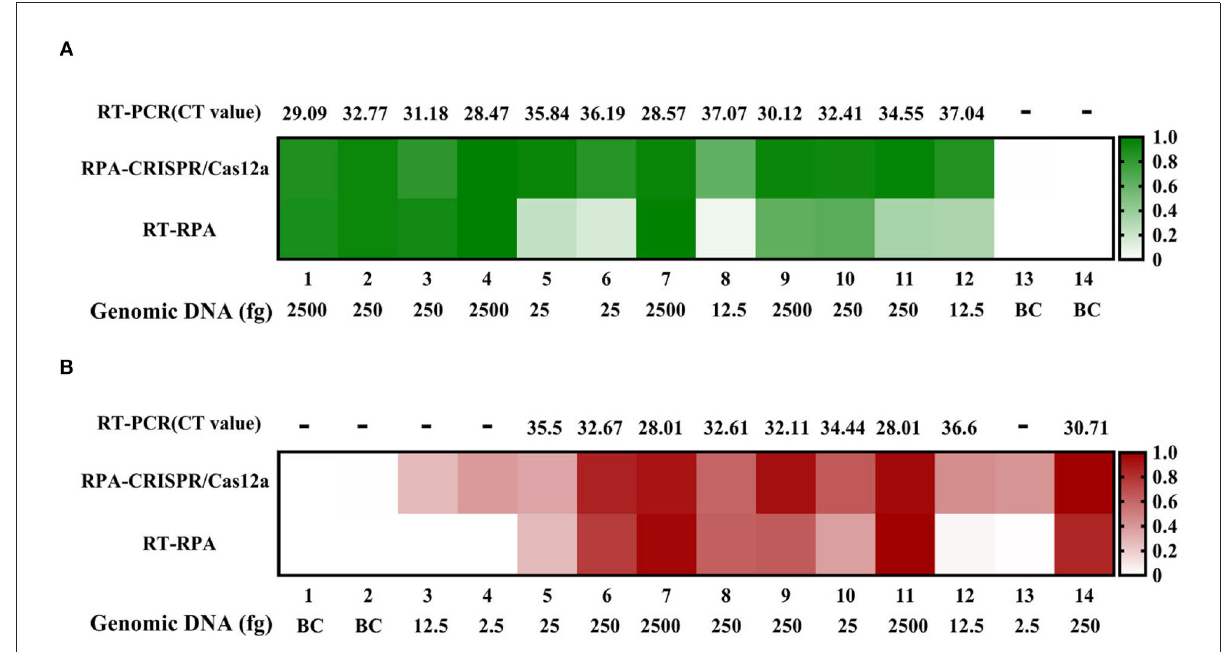
FIGURE6 Sewage and blood sample tests by RT-RPA, RPA-CRISPR/Cas12a, and RT-PCR assays. (A) Sewage samples test. (B) Blood samples